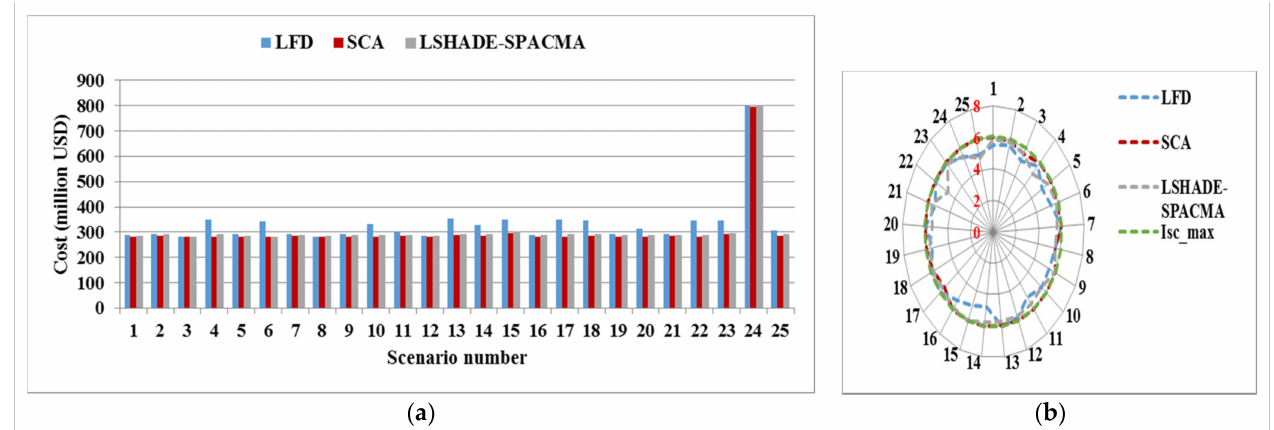
Figure 6. Comparison between LFD, SCA, and LSHADE-SPACMA to solve the G&TEP problem: ( a ) the planning cost, ( b ) the contour of maximum short-circuits currents.